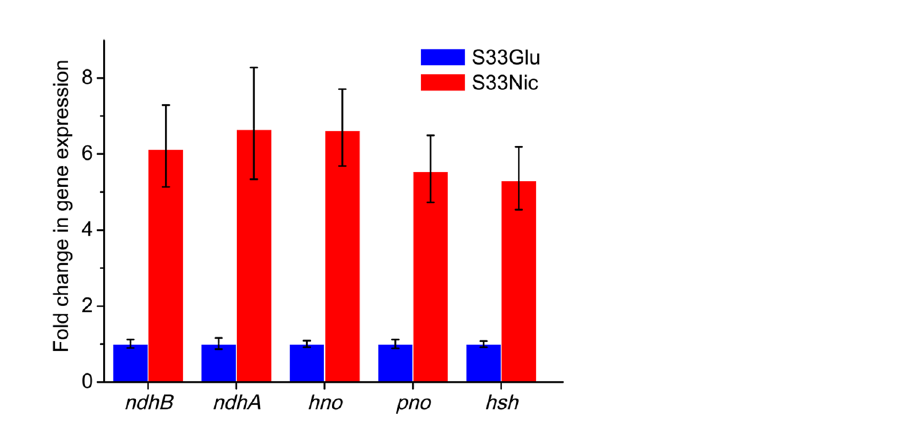
Figure 7. qRT-PCR analysis of the expression levels of five genes involved in nicotine degradation in A . tumefaciens S33. S33Glu, cells grown in glucose-ammonium medium; S33Nic, cells grown in nicotine medium. The expression levels in glucose-ammonium medium were used as control and set as